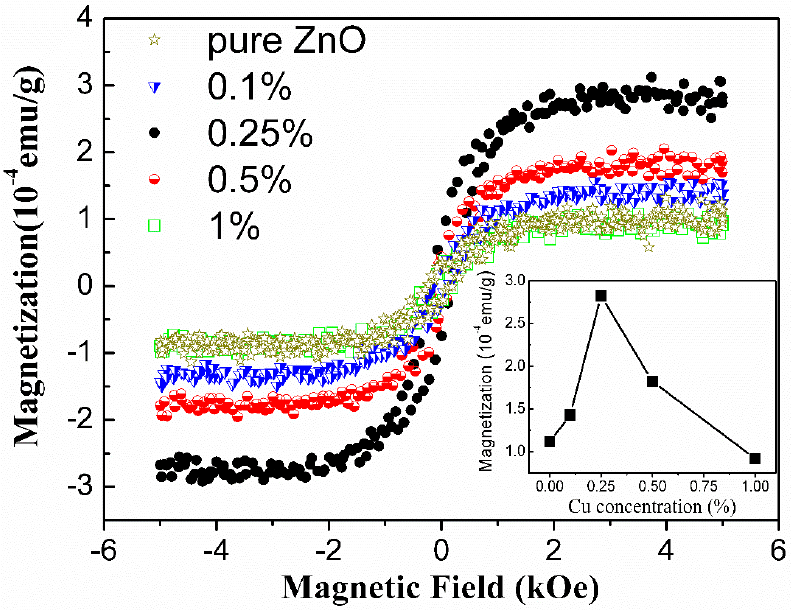
Figure 3. The room temperature field-dependent magnetization (M–H) curves of undoped and lightly Cu-doped ZnO nanocrystals with different Cu concentrations.